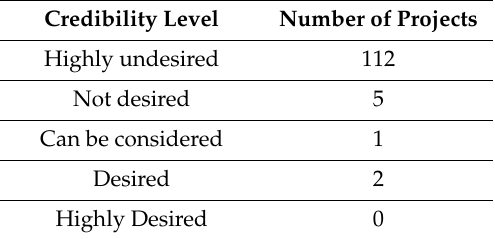
Table 10. Statistical analysis of credibility assessment of undelivered projects (Total projects = 120).